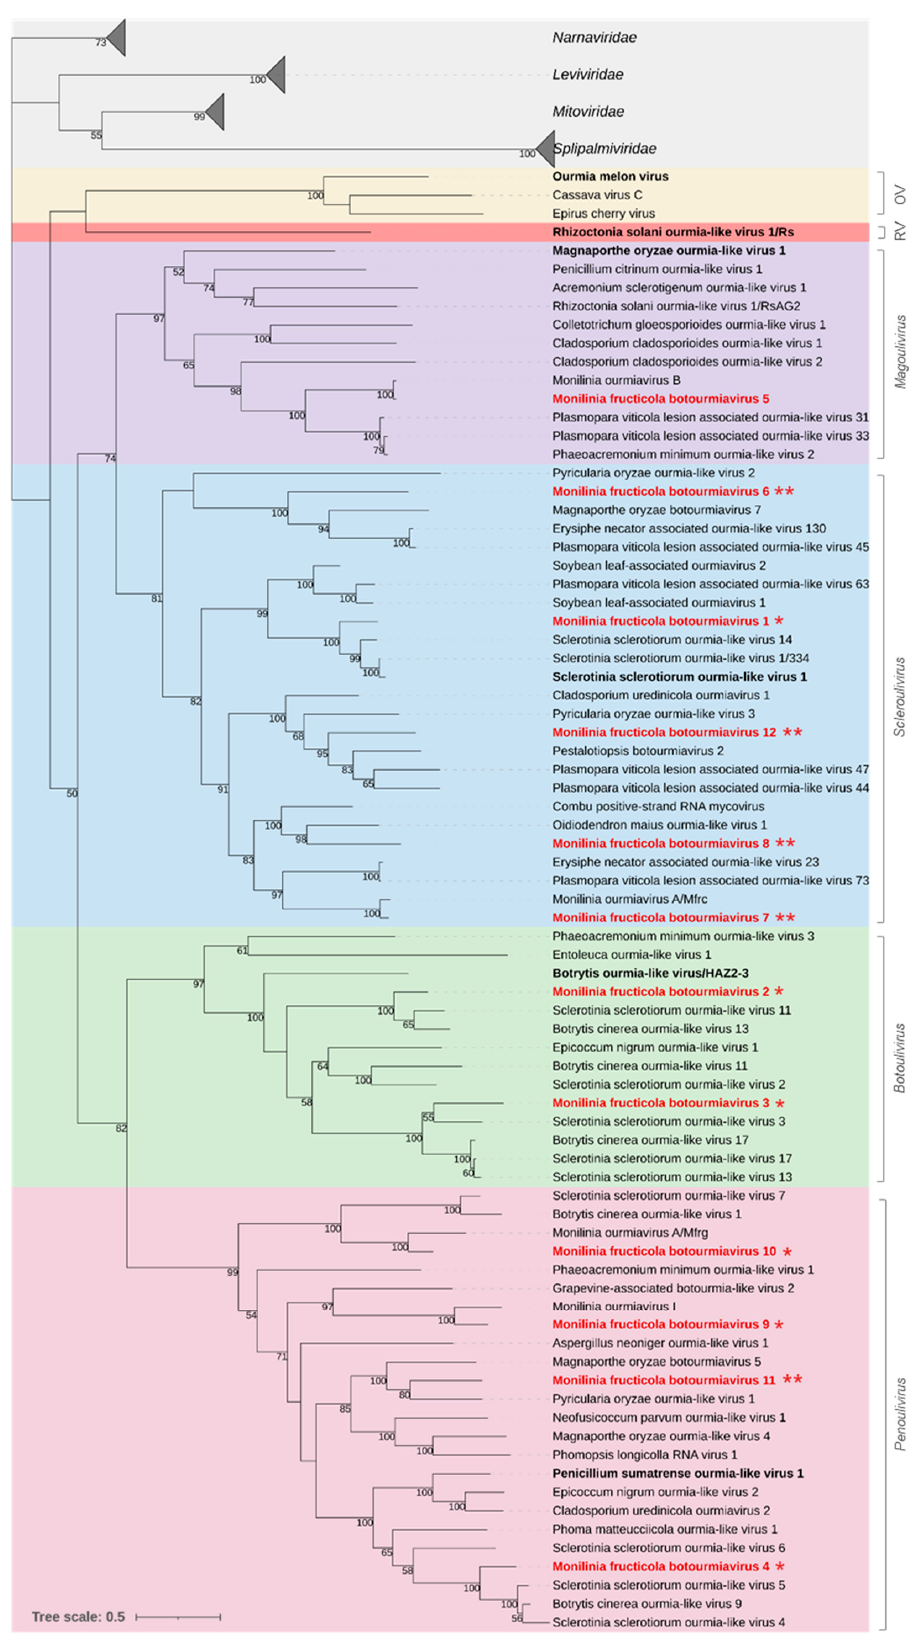
Figure 2. Maximum likelihood phylogenetic tree based on multiple amino acid sequence